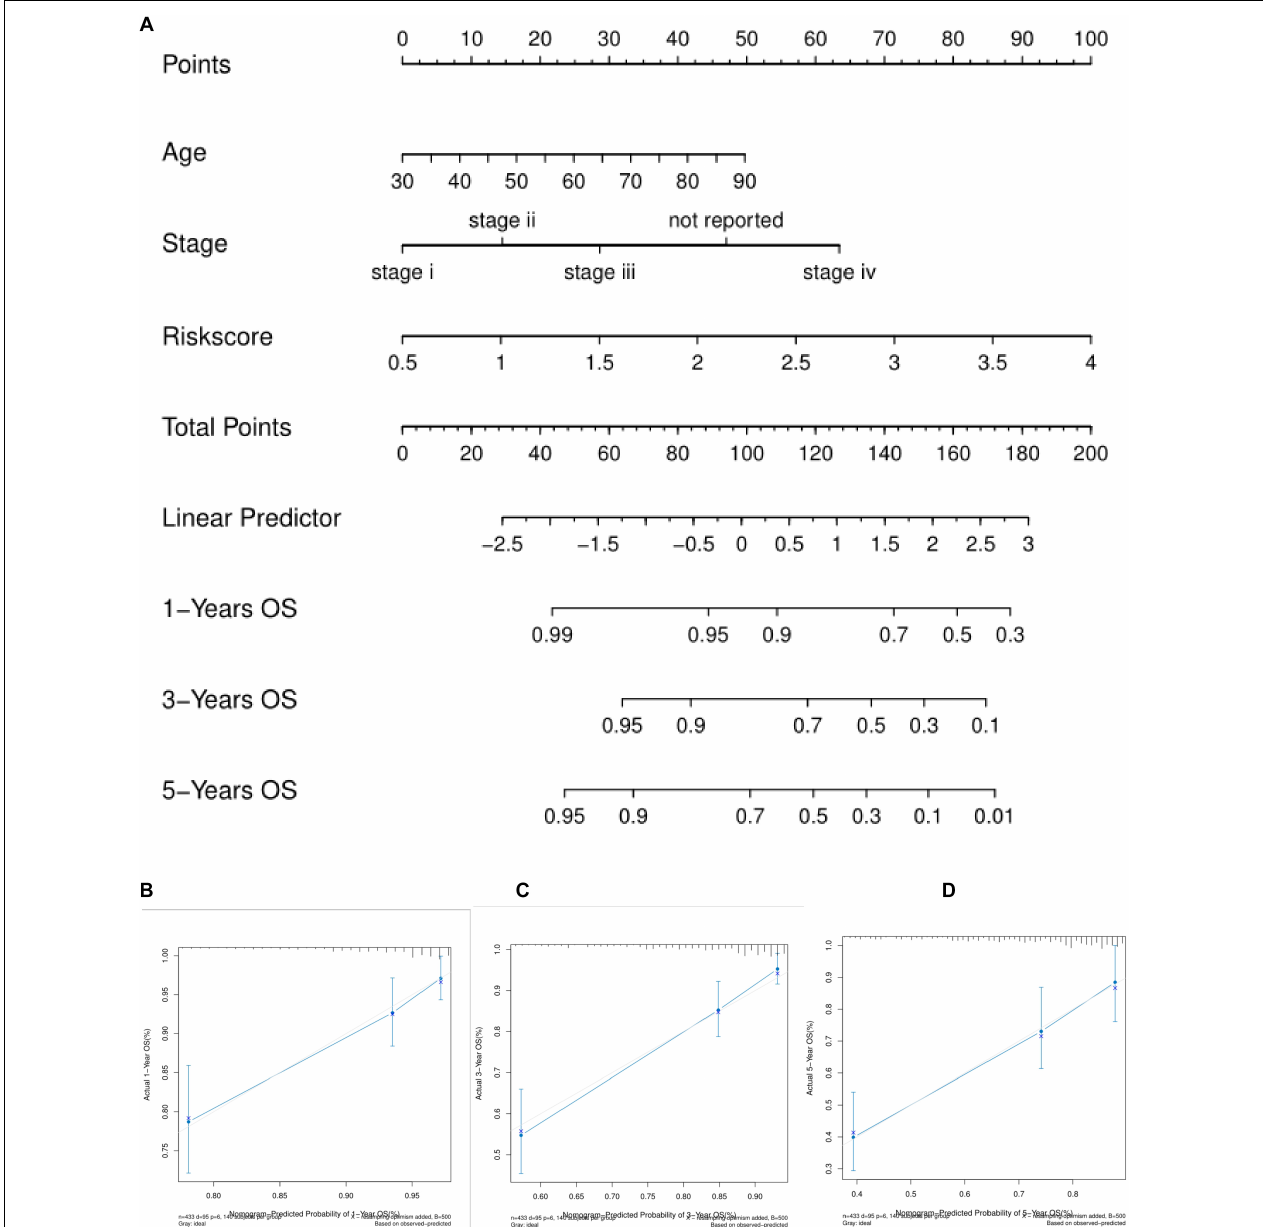
FIGURE 5 | Nomogram predicts the survival of patients with colon cancer. (A) Nomogram to predict the probability of 1, 3, and 5 years OS in colon cancer patients. (B–D) Normative curve for predicting the probability of 1, 3, and 5 years OS colon cancer patients. the X axis represents nomogram predicted survival and the Y axis represents the actual